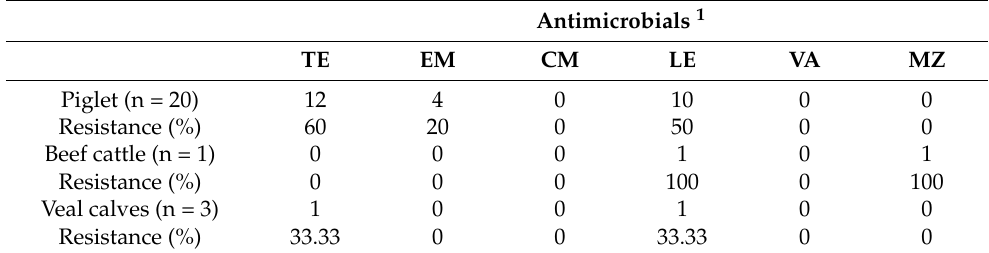
Table 2. Susceptibility profiles of the Clostridioides difficile isolates grouped by animal